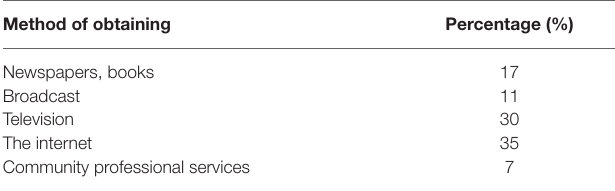
TABLE 2 | Access to mental health knowledge.